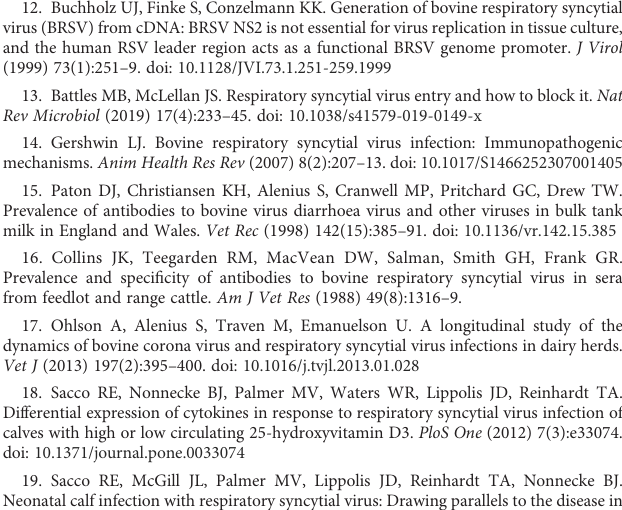
SUPPLEMENTARY FIGURE 1 Arti fi cial antigen presenting cells co-expressing BoLA DR and CD80 molecules. HEK-293 cells were transfected with plasmids encoding BoLA DR and CD80. Single cell populations were isolated, expanded, and assessed for transgene expression via fl ow cytometry. Gating strategy for phenotyping analysis (A). Population of co-transfected HEK 293 cells with each BoLA DR allele (B). SUPPLEMENTARY TABLE 1 Primer sequences used to amplify DRA, DRB3, and CD80 for aAPC